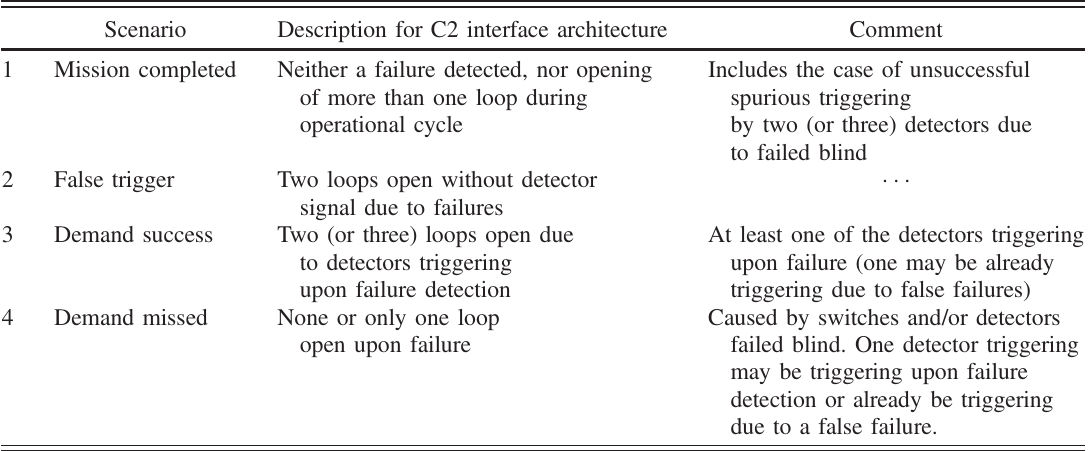
TABLE VI. Definition of scenarios for case C2 interface